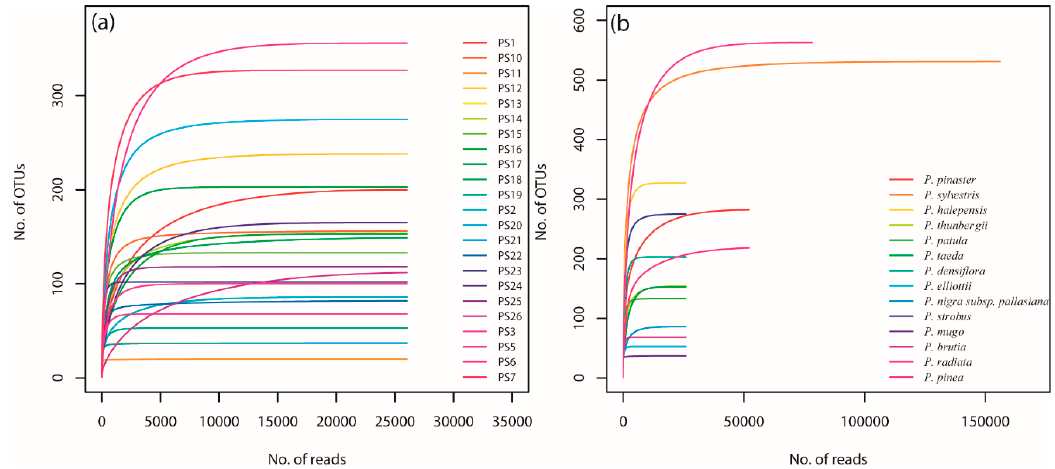
Figure 1. Diversity of fungi in a range of Pinus spp. seedlots. ( a ) Rarefaction curve of operational taxonomic units (OTUs) in each seed sample plotted against the number of pyrosequencing reads excluding singletons. The numbers represent sample ID (Table 1); ( b ) Rarefaction curve of OTUs for each Pinus species plotted against the number of pyrosequencing reads excluding singletons. OTUs were clustered conservatively at 97% similarity.